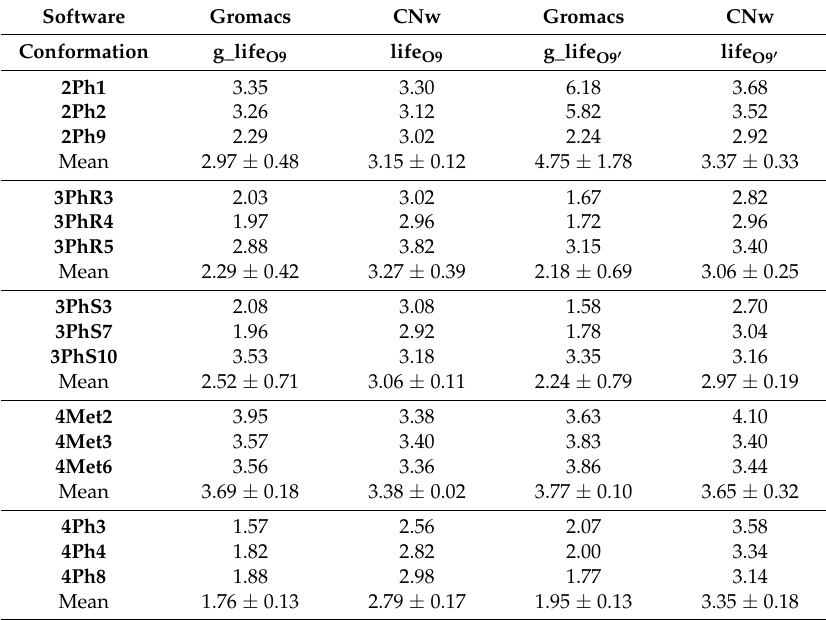
Table 3. Lifetimes (in ps) of the uninterrupted hydrogen bonds between the LIGNOLs and the TIP4P solvent.